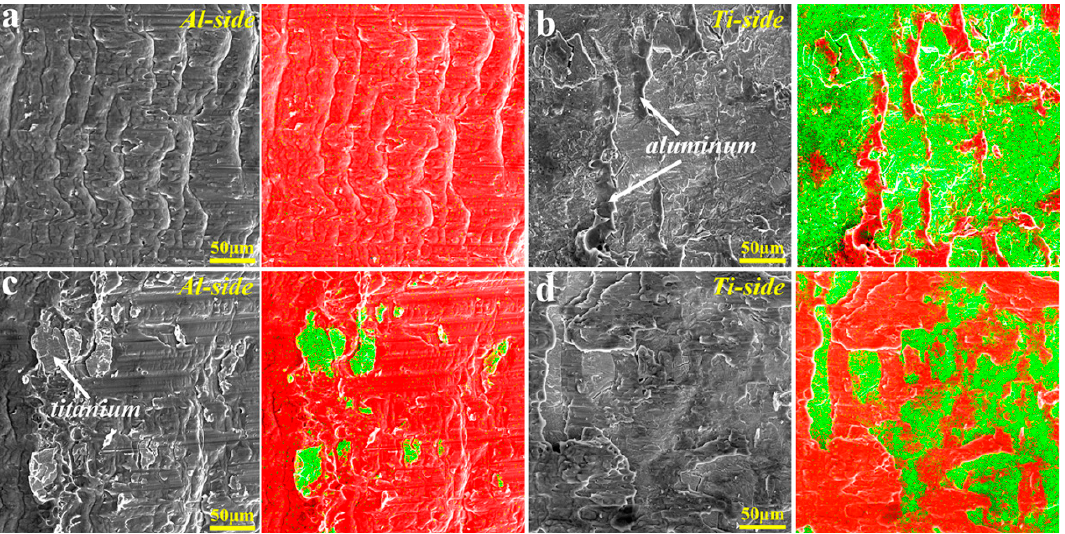
Figure 6. SEM images of the shear surfaces of the Al/Ti LMCs under the conditions of the conventional process ( a , b ) and D550 process ( c , d ).